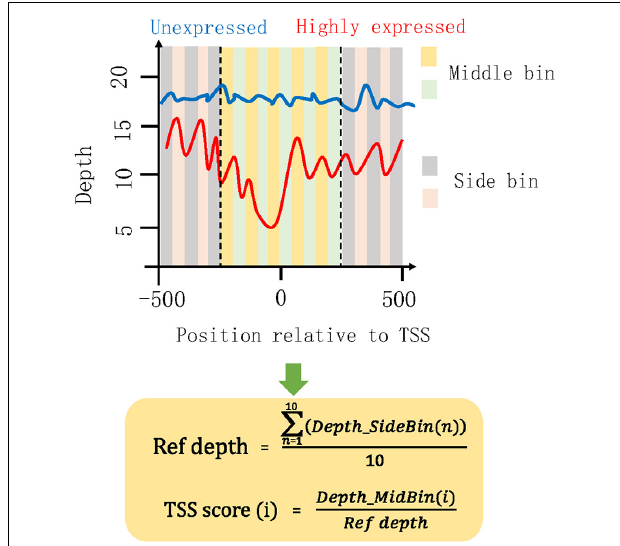
FIGURE 2 | Illustration of algorithm for measuring TSS coverage profile. The coverage of 1,000 bp region surrounding TSS was investigated. Then, the 1-kb region was separated into 20 small bins with a size of 50 bp. We defined the 10 bins in the middle of this 1-kb region as the middle bins and the outward 10 bins on both sides as the side bins. Depth_SideBin(n) represents the depth for the n th side bin. The average depth ( Ref depth ) in all side bins was calculated and used for the normalization of middle bins. Here, we proposed a “TSS score” as the normalized coverage for each middle bin. i represent the i th middle bin. All the 10 TSS scores of middle bins were used to measure the chromatin states in this TSS region. A list of high TSS scores would represent a high coverage around the TSS, indicating that some specific proteins or nucleosomes were presented in this region and protected the cfDNA here from digestion. Under this circumstance, the occupied TSS regions would hamper the binding of transcription factors and result in a low expression level of this gene. Conversely, the low TSS scores were associated with high expression level of this gene.